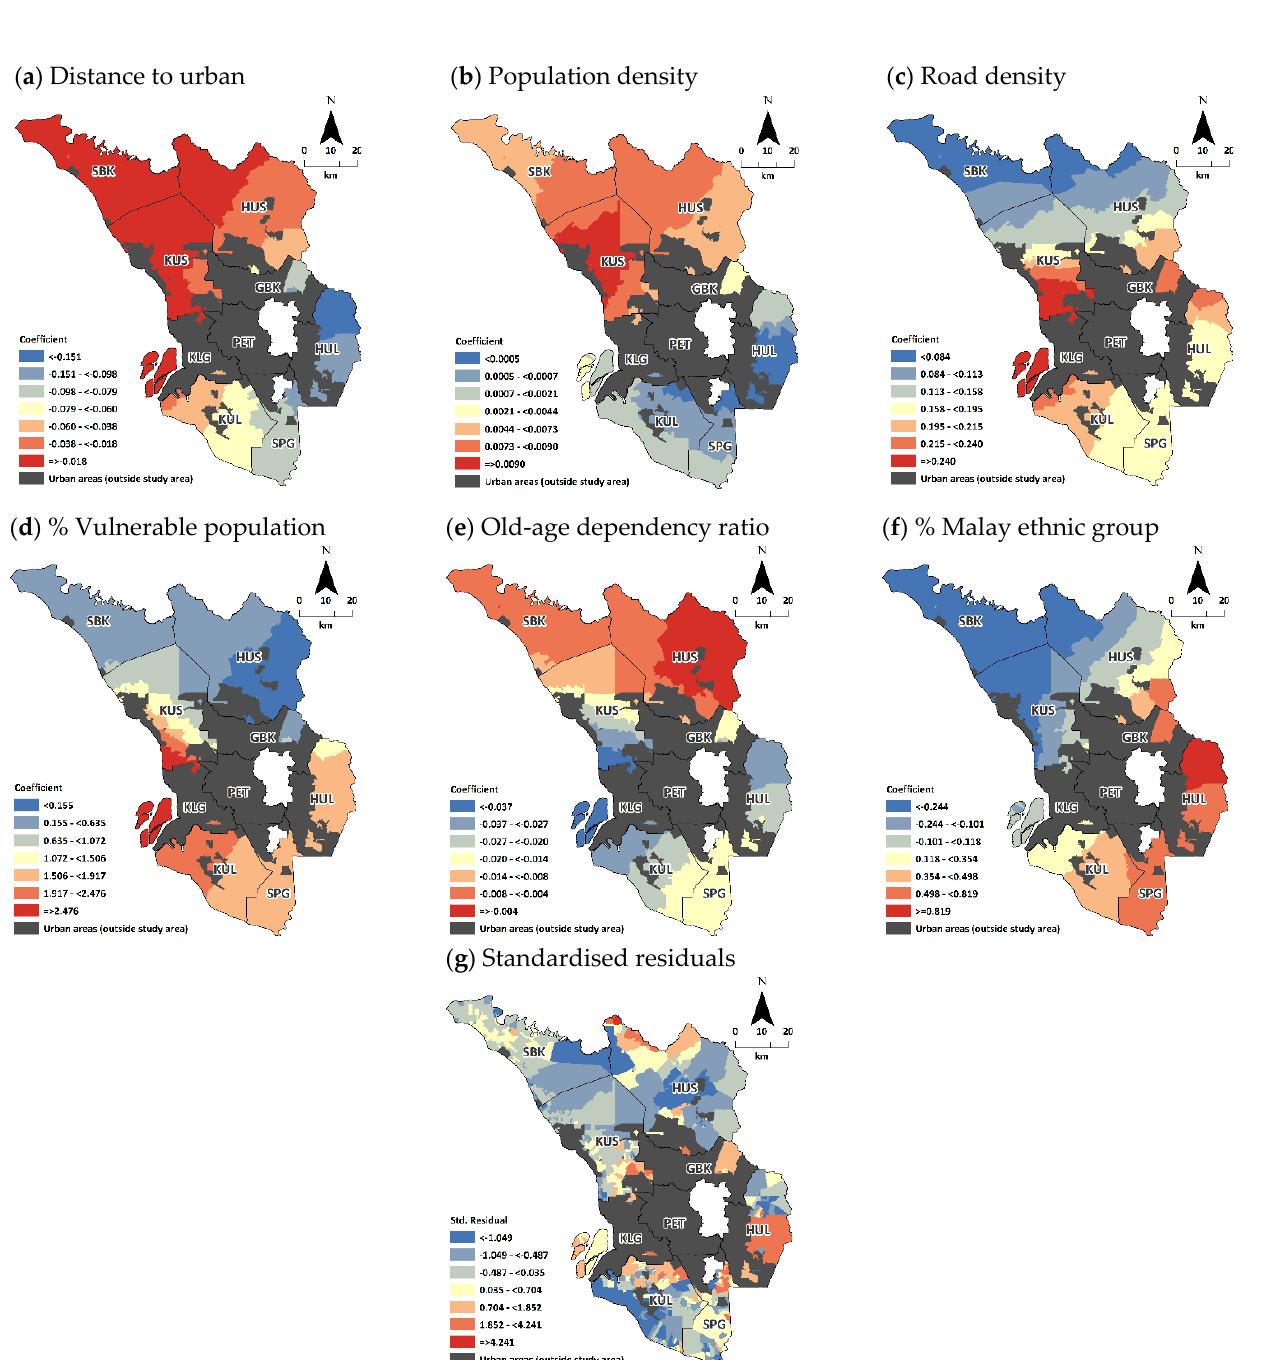
Figure 3. Regression coefficient of each explanatory variables ( a – f ) and standardized residuals ( g ) of the GWR on Astot score.